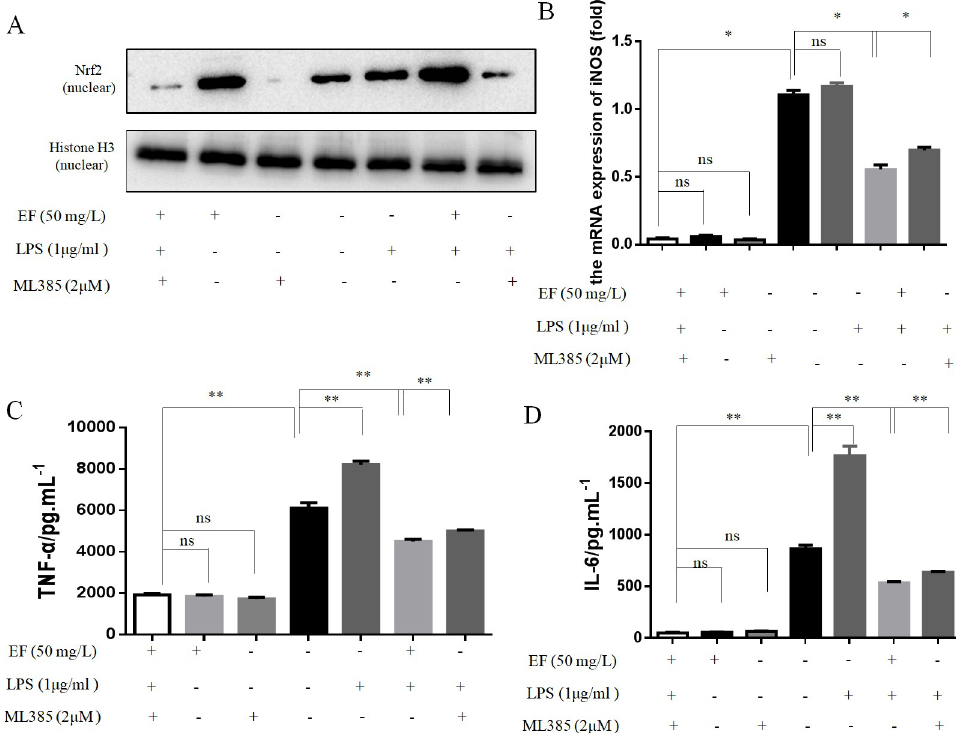
Fig 7. The inhibition of Nrf2 reversed the protective effect of EF on mRNA iNOS and production of TNF- α and IL- 6. A: The protein levels of Nrf2 in nuclear were determined by Western blotting analysis using specific antibodies. B: The mRNA levels of iNOS were determined by quantitative real-time PCR. C/D: The supernatant levels of TNF- α and IL-6 were identified by ELISA.